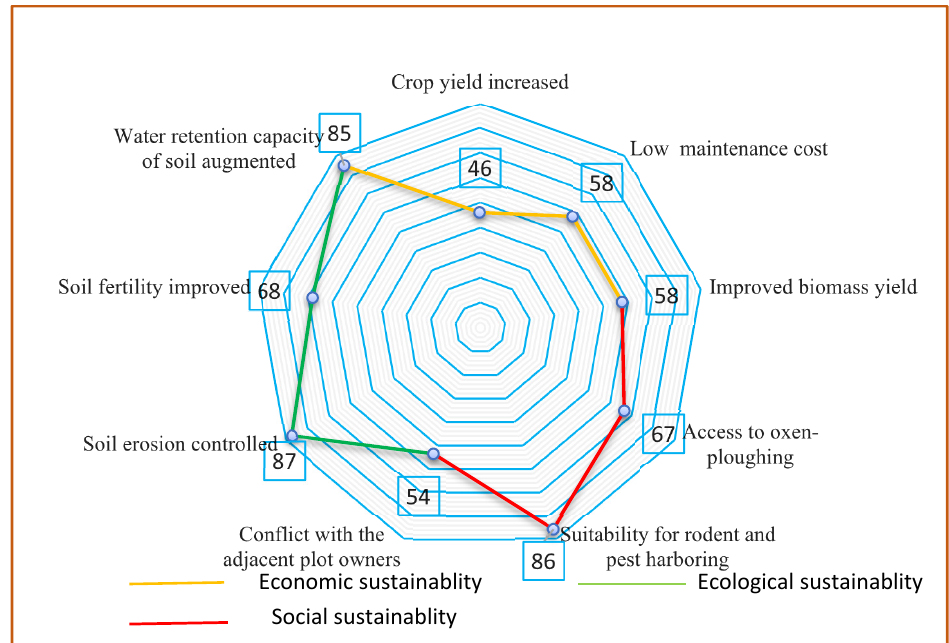
Figure 6. Sustainability of biological practices.